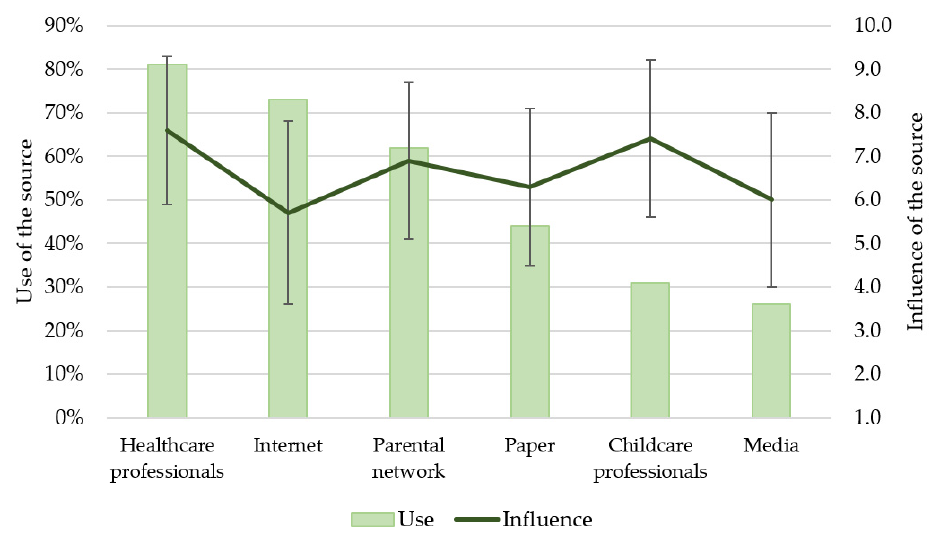
Figure 2. Parental perception of the influence of each information source on their feeding practices, and degree of usage for each source. Left axis: percent of use among all respondents (n = 1001); right axis: self-perceived influence (Mean +/ − SD; scale from 1 to 10) of the information source among those who reported to use that corresponding source.